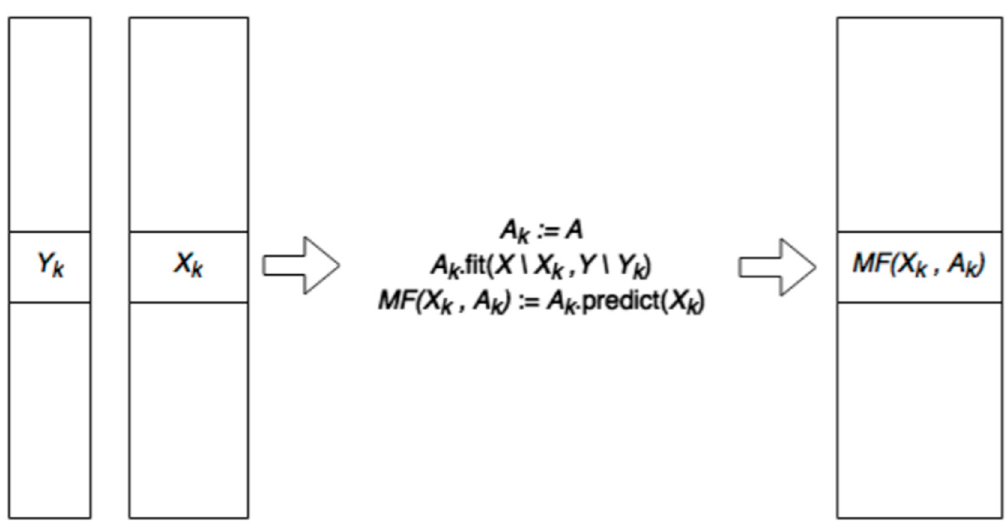
Figure 5. Staking of heterogeneous groups of algorithms.